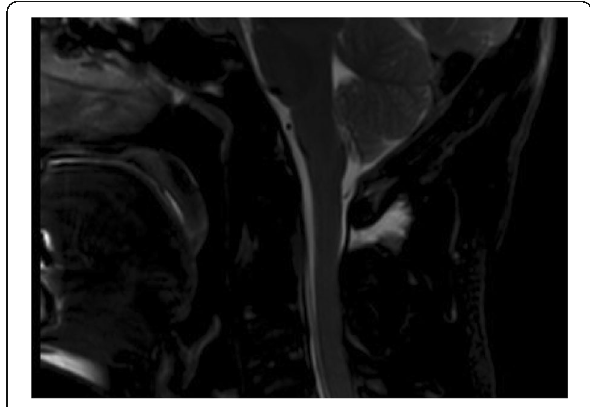
Fig. 2 (abstract P0358). See text for